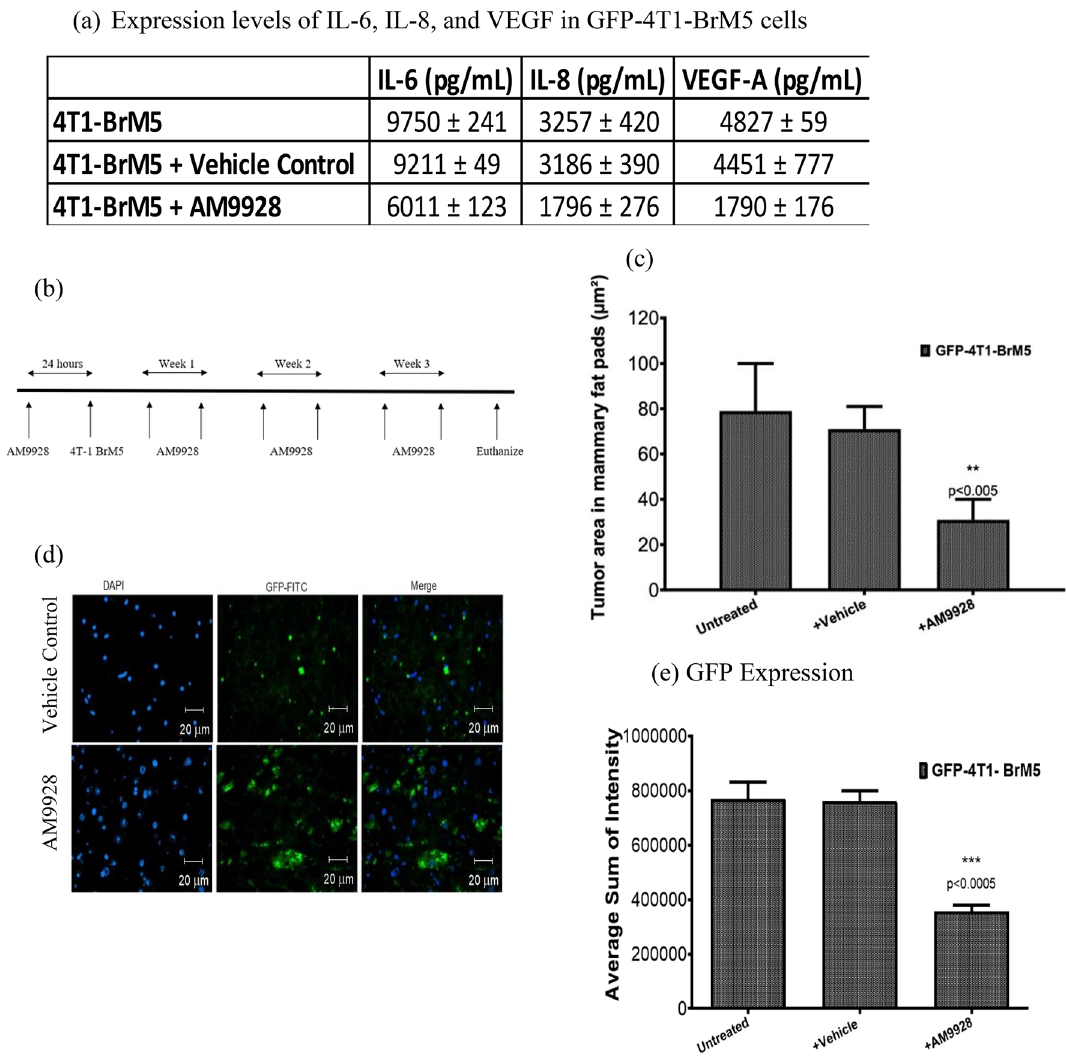
Figure 4. In vivo effects of AM9928 on TNBC tumor growth and brain metastasis: ( a ) Expression levels of IL-6, IL-8, and VEGF in GFP-4T1-BrM5 cells untreated and following treatment with AM9928: Cell supernatant samples were prepared from GFP-4T1-BrM5 cells either treated with vehicle control or with AM9928. The levels of the murine cytokines/chemokines were measured using specific ELISA assays for IL-6, IL-8, and VEGF-A (R&D Systems ® ELISAs). Data shown are representative of at least three independent assays performed on triplicate wells. The error bars indicate standard deviations. * p < 0.05 as compared to vehicle control, ** p < 0.005 as compared to vehicle control and *** p < 0.0005 as compared to vehicle control. ( b ) Schematic presentation of time injection of AM9928 and GFP-4T1-BrM5 cells: AM9928 (at 10 mg/kg) or vehicle control were injected by I.V. twice a week for 3 weeks. ( c ) Tumor formation in mammary fat pads following treatment with AM9928: Murine tumor formation in mammary fat pads were measured at day 28: n = 10 mice/treatment; * p < 0.05, Mann–Whitney U ‐ test; ** p < 0.005 as compared to vehicle control. ( d ) Detection of GFP-positive cells in brain tumors: GFP–4T1-BrM5 tumor cells were administered to the mammary fat pads as compared to control mice and were treated with vehicle control or with AM9928. Murine tumor cells in brain were detected by GFP immunostaining (GFP antibodies 1:50 dilutions; Abcam)(green) and their respective controls were used under the same standardized conditions. Brain nuclei were counterstained with DAPI (blue). n = 10 mice/treatment; These are representative images of over 50 images from three independent experiments. Scale bar = 20 μm. ( e ) Quantitative analysis of tumor cells in the brain: Murine tumor cells in brain were detected by GFP immunostaining as described above. The tumor areas at day 28 were detected by immunostaining with GFP antibody: n = 10 mice/treatment; * p < 0.05, Mann–Whitney U ‐ test; ** p < 0.005 as compared to vehicle